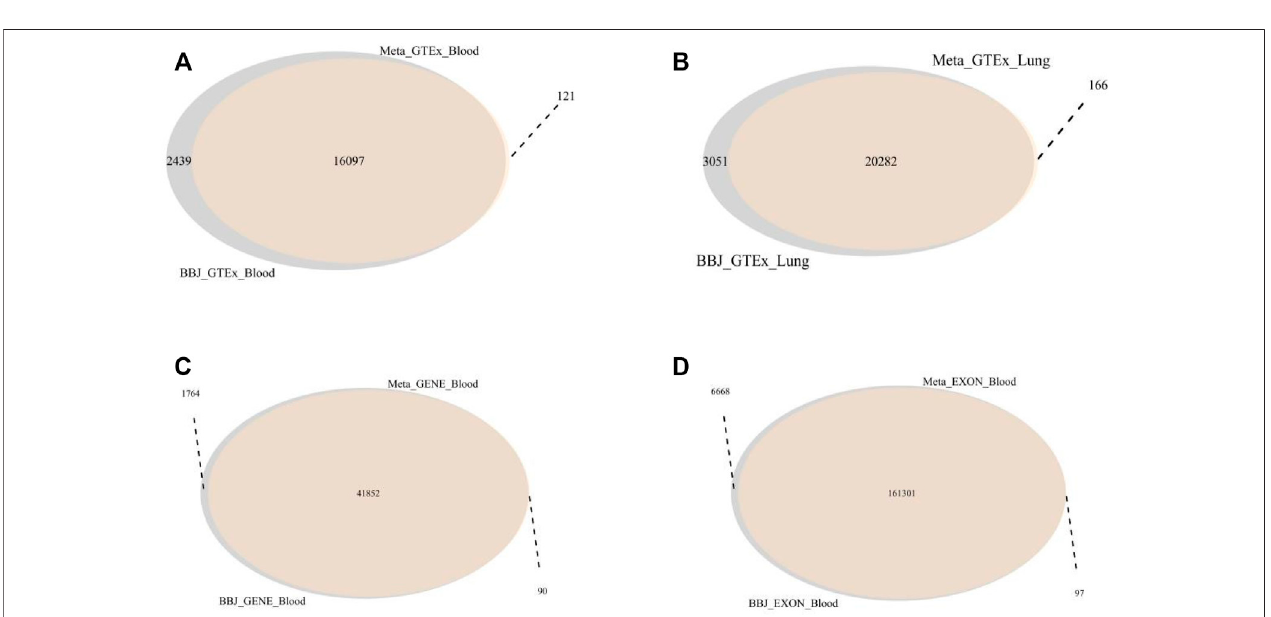
FIGURE3| Theoverlappinggenesbetween twodifferentSMR datasets. (A) The overlap genesofMeta_GTEx_Blood and BBJ_GTEx_Blood. 16,097genes were overlapped. (B) The overlap genes ofthe Meta_GTEx_Lung and BBJ_GTEx_Lung. There were 20,282overlapped genes. (C) The overlap genes of Meta_GENE_Blood and BBJ_GENE_Blood. These two datasets have 41,852 identical genes. (D) the overlap genes of Meta_EXON_Blood and BBJ_EXON_Blood. These two datasets have 161,301 identical genes.